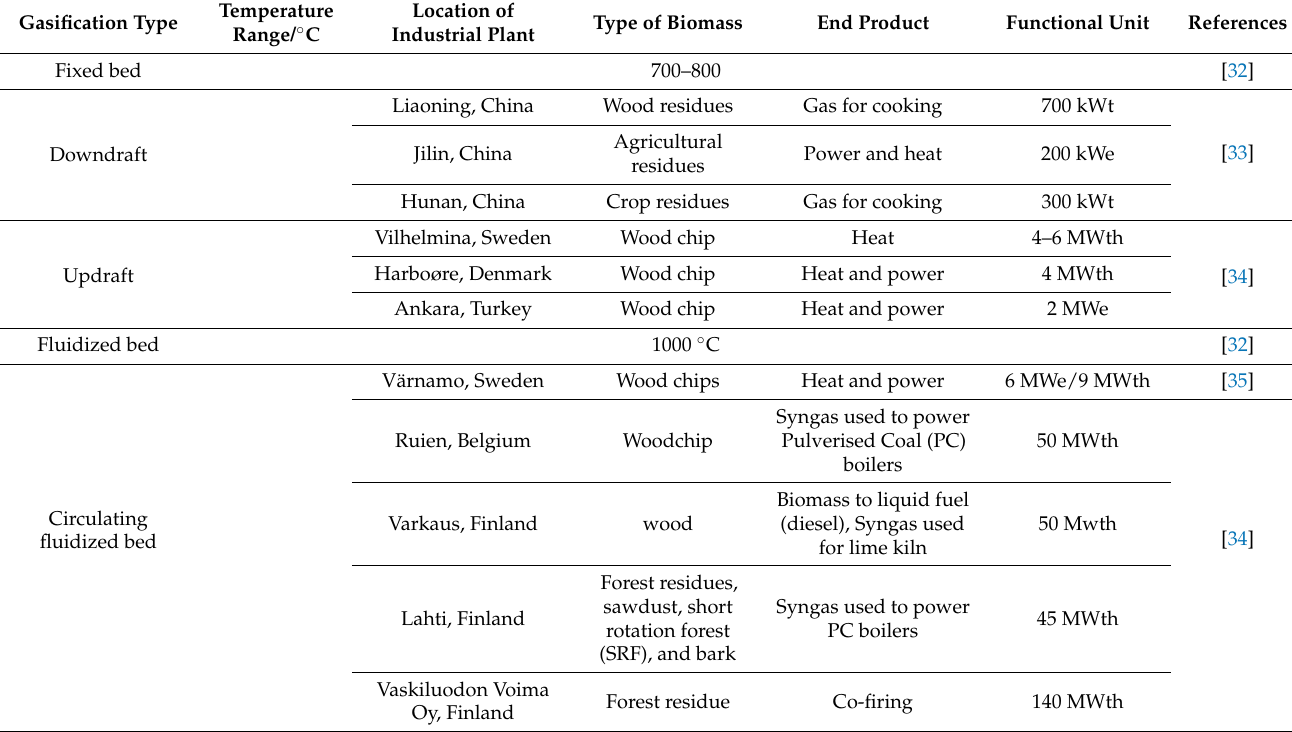
Table 1. Classification of gasification plants at industrial